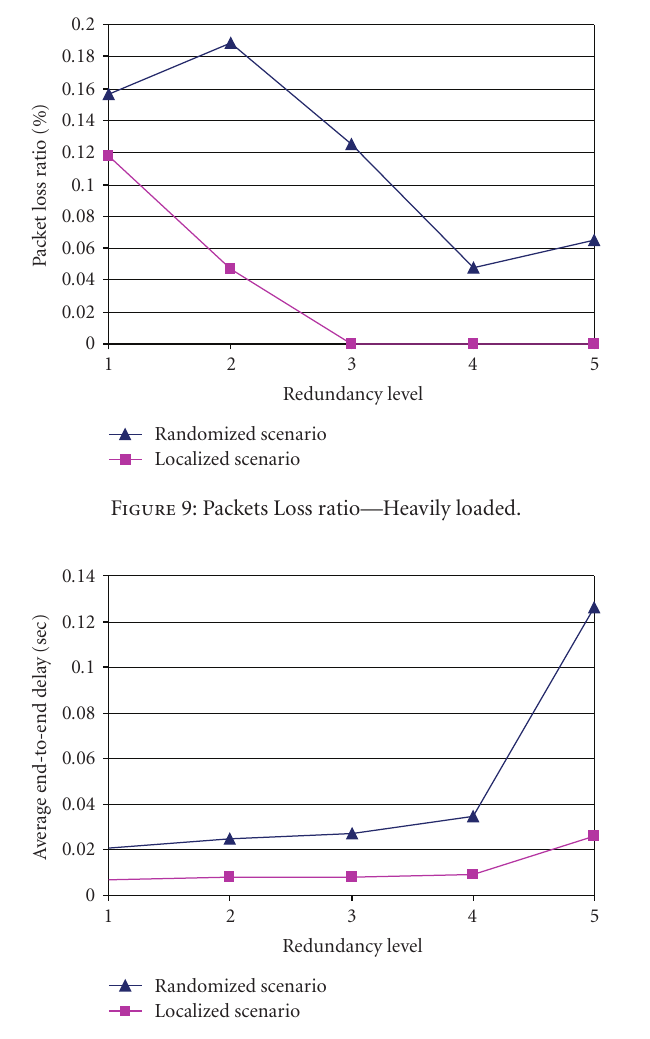
Figure 13: PSNR—Heavily